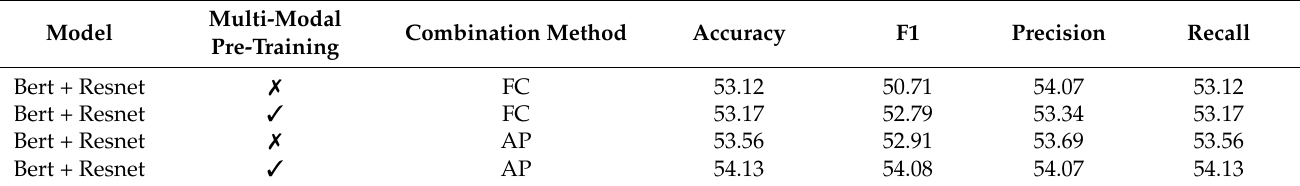
Table 5. Model performance on VQA dataset v2. (FC = Fully-connected, AP = Attentive pooling). Model